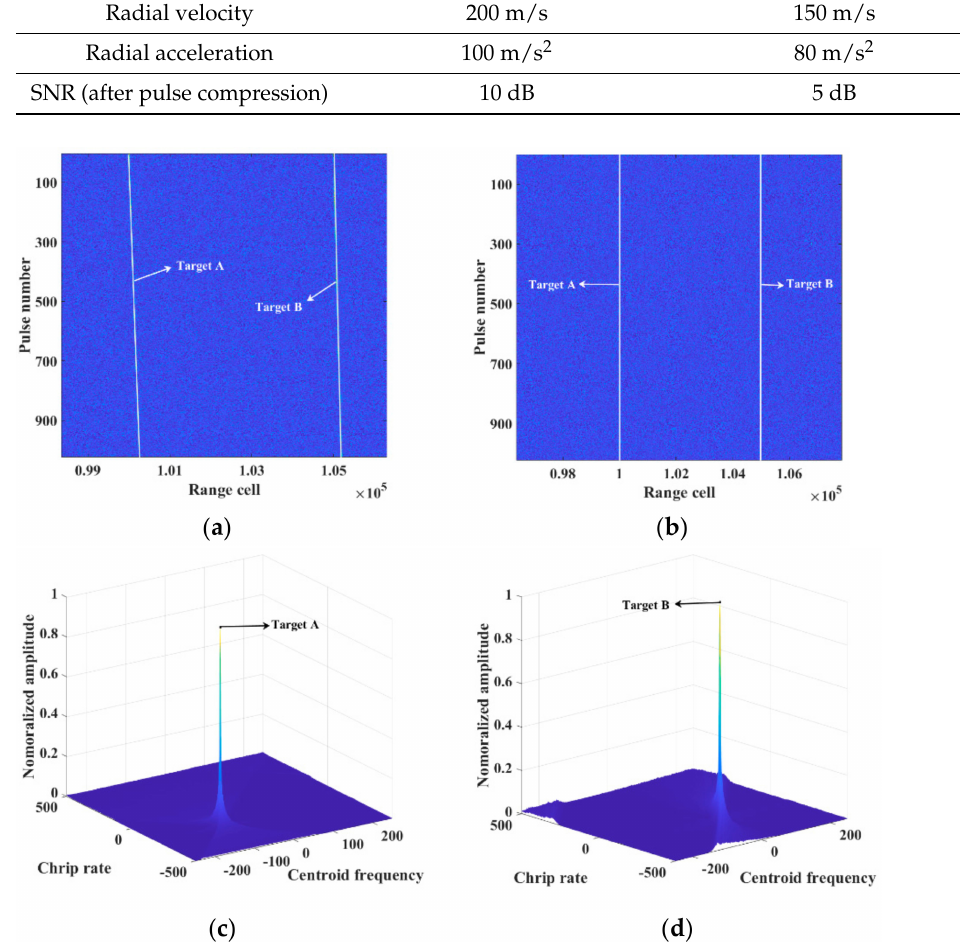
Figure 5. Coherent integration for multiple targets via the proposed method: ( a ) Result after pulse compression; ( b ) Result after range migration correction; ( c ) Coherent integration result of target A; ( d ) Coherent integration result of target